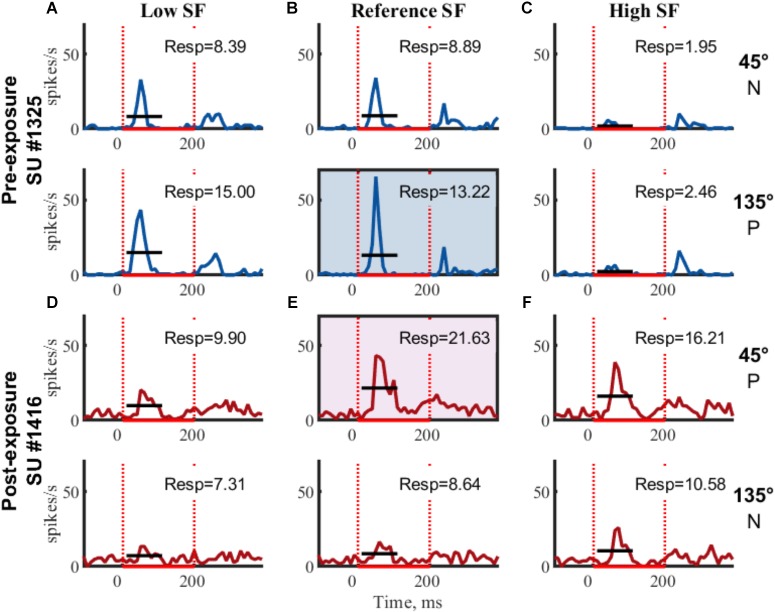
Example SUs. PSTHs of raw FR (mean across trials) for two example SUs are shown for each of the six gratings. Rows indicate same orientation (P, preferred orientation; N, non-preferred orientation; determined post hoc), columns indicate same SF. Boxed PSTHs indicate reference stimulus for normalization (see Table 2). Resp = average FR from 15 to 115 ms in spikes/s;  stimulus presentation; — mean response FR.